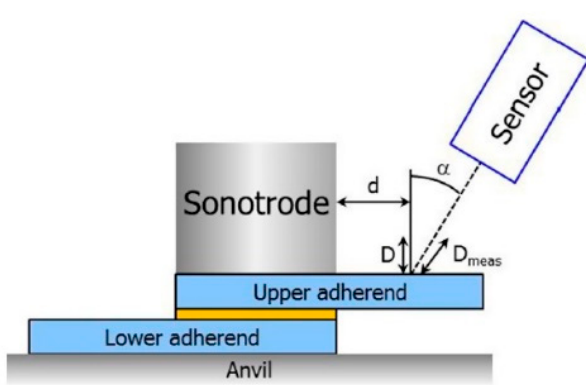
Figure 3. Schematic drawing of determination of amplitude transmission using a tilted sensor. Adapted from Reference [136].